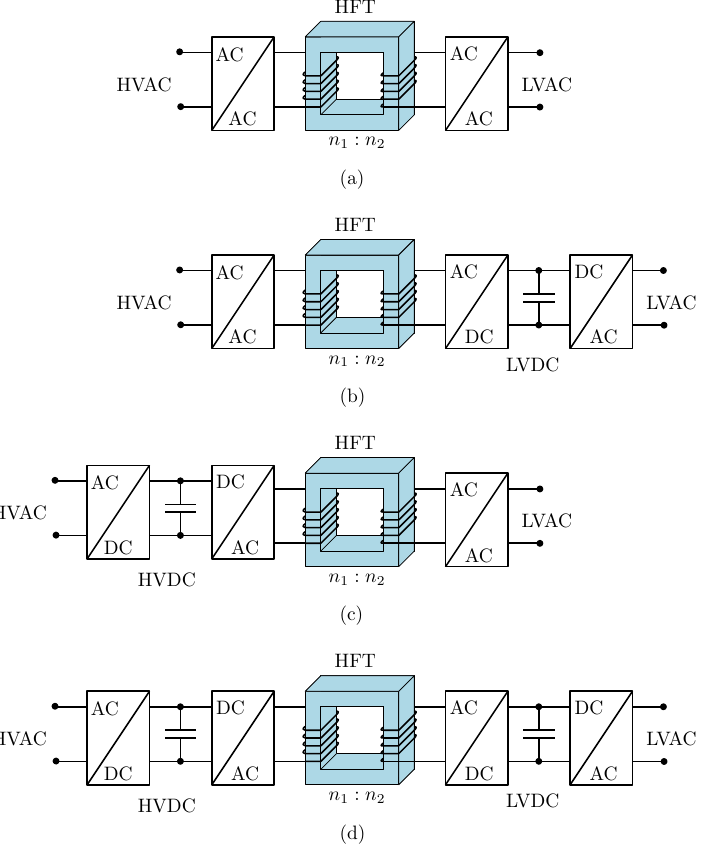
Figure 7. Different topologies of SST from a power conversion stages point of view: ( a ) single-stage (type A); ( b ) two-stage with LVDC link (type B); ( c ) two-stage with HVDC link (type C); ( d ) three-stage with LVDC and HVDC link (type D) [121].